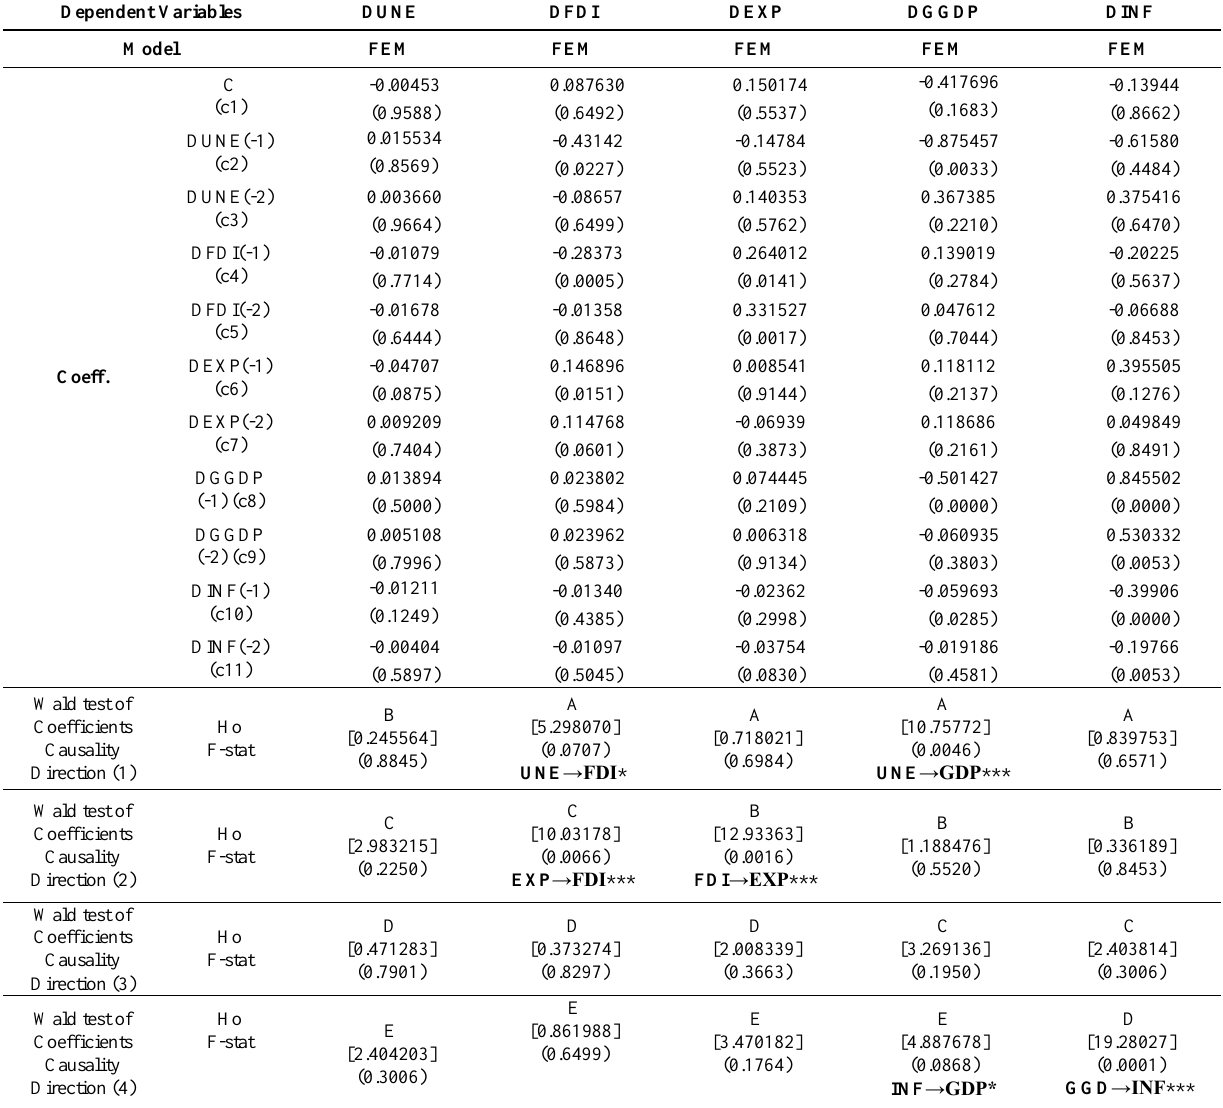
Table 7. Panel data Granger causality tests for the group of